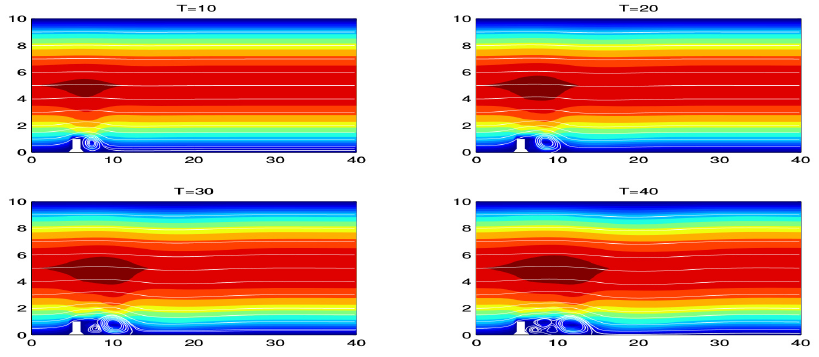
Figure 2. Four snapshots ( t = 10,20,30, and 40) of a full-resolution direct numerical simulation of the Navier–Stokes Equations (NSE). Shown are streamlines overlaid above speed contours | v h ( x , t ) | . This figure was originally published in